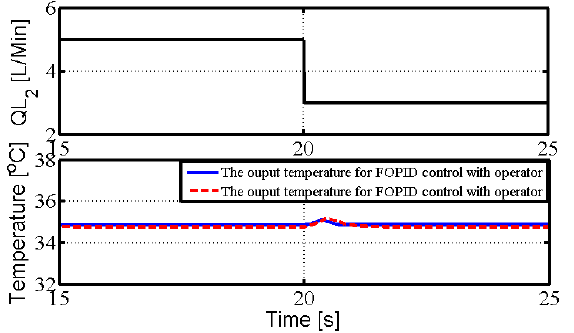
Figure 22. Antidisturbance performance to the input flow rate of cold-fluid